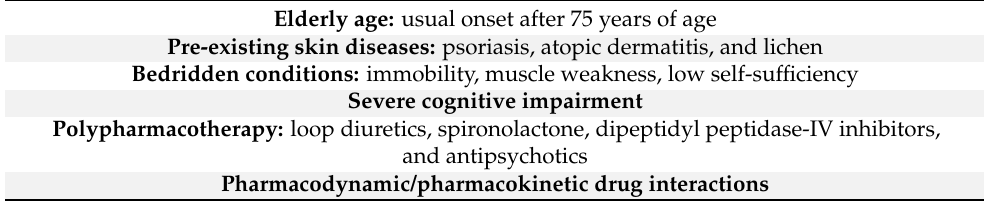
Table 3. Bullous pemphigoid risks factors in patients with neuropsychiatric disorders. Elderly age: usual onset after 75 years of age Pre-existing skin diseases: psoriasis, atopic dermatitis, and lichen Bedridden conditions: immobility, muscle weakness, low self-sufficiency Severe cognitive